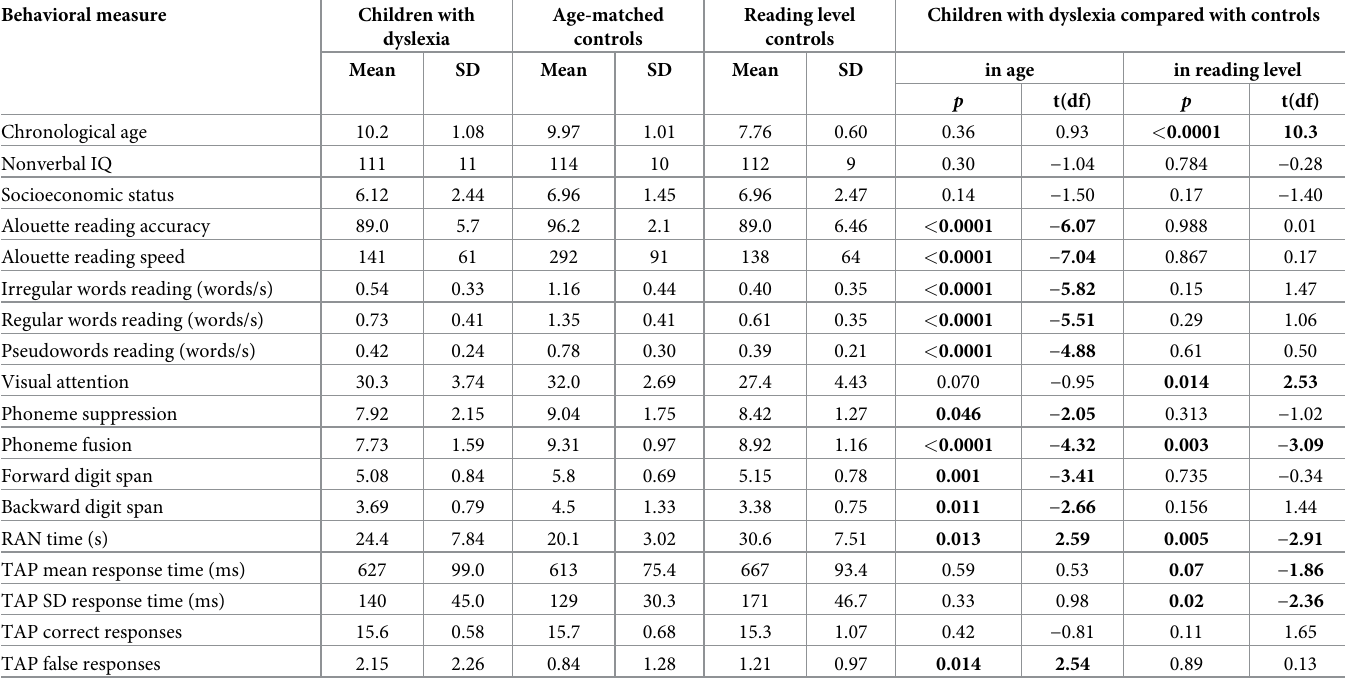
Table 1. Mean and standard deviation of behavioral scores in each reading group of 26 children and comparisons ( t tests) between